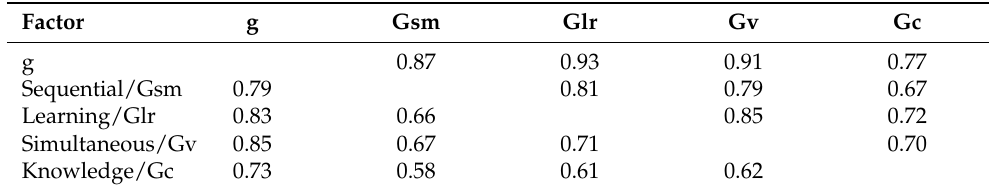
Table 7. Second-order CHC model: Loadings of first-order factors on the general factor and implied correlations of first-order factors for 5- and